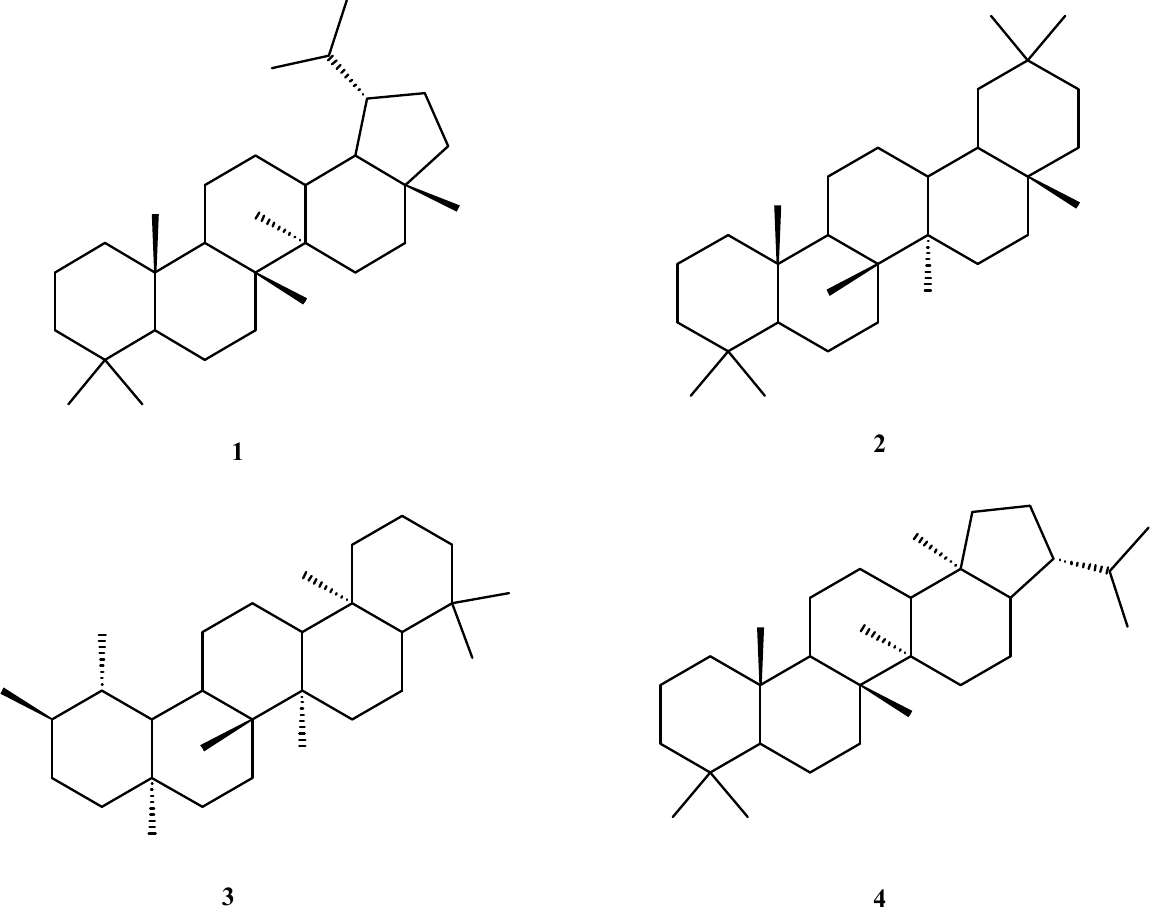
Figure 1. The chemical structures of lupane ( 1 ), oleanane ( 2 ), ursane ( 3 ), and hopane ( 4 ) scaffolds.